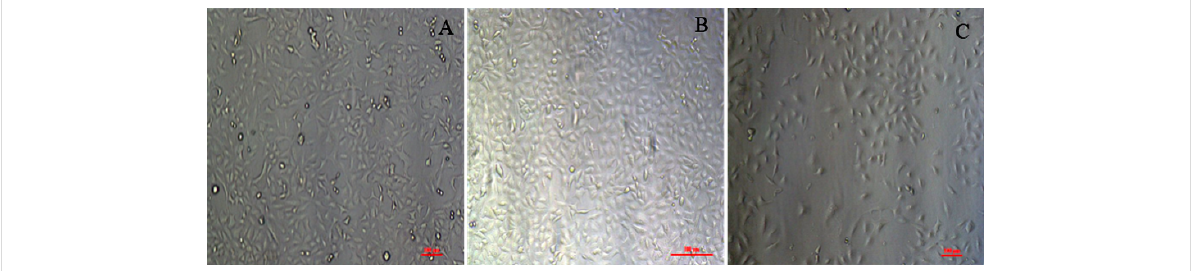
Figure 9: Morphology of A549 cells after treatment with blank PVI nanoparticles or polyplex. (A) Control; (B) blank polymer nanoparticles; (C) poly- plex. The scale bars represent 100 μ m.